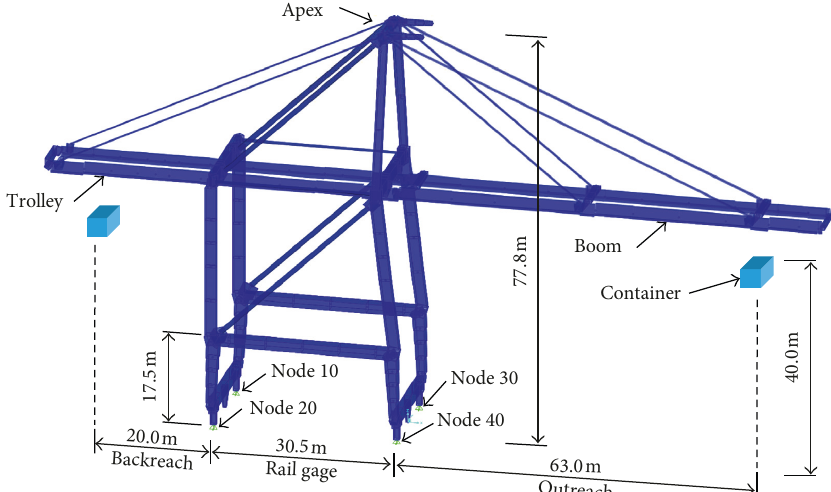
Figure 1: 3D numerical FE model of Korea STS container crane.